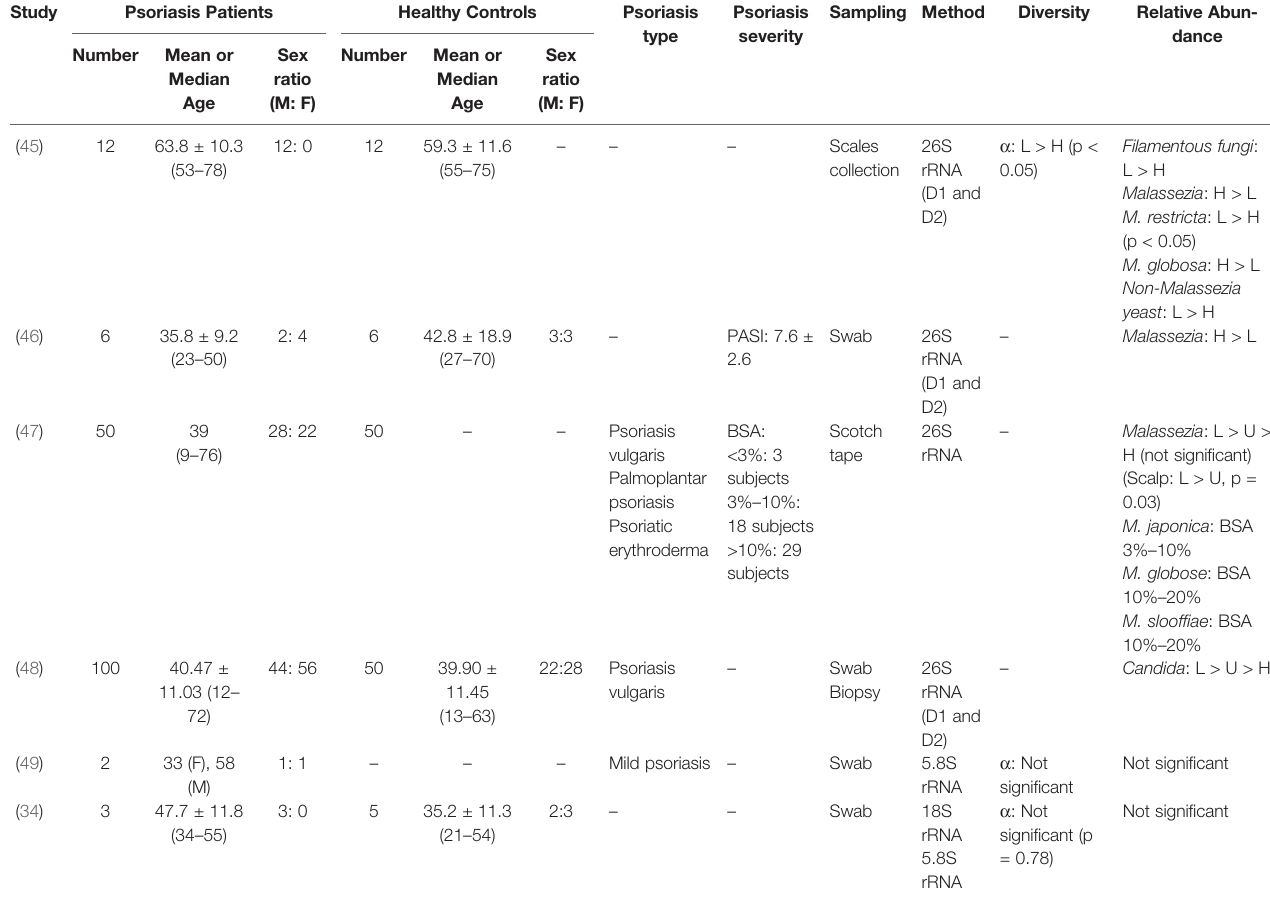
TABLE 3 | Summary of published clinical trials involving skin fungus microbiota in psoriasis.